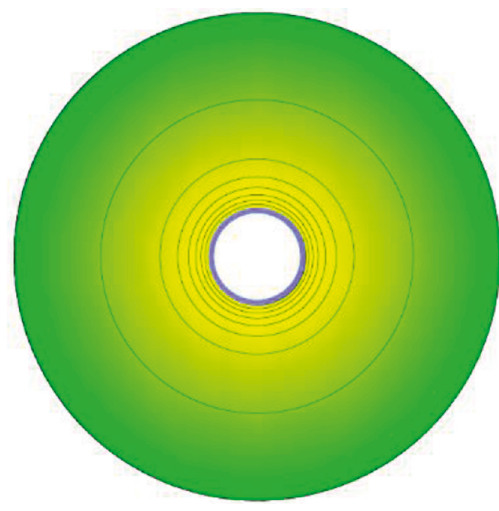
Figure 5: Eight layers in plastic area. Table 1: Parameters of materials.